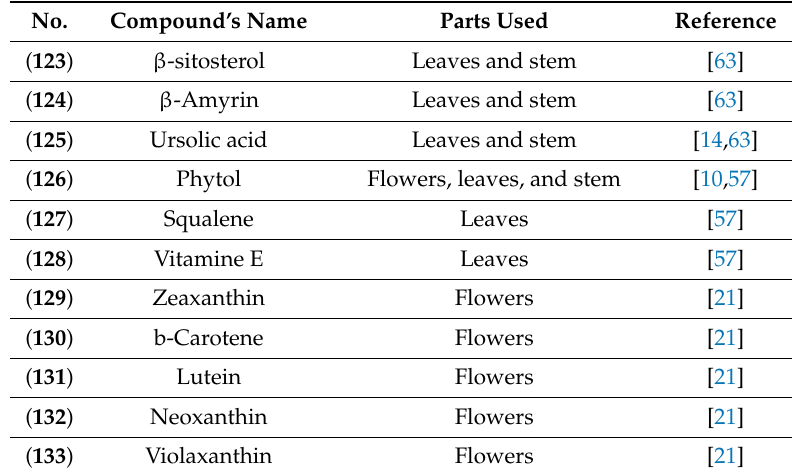
Table 7. The steroids and terpenes from A. cathartica .